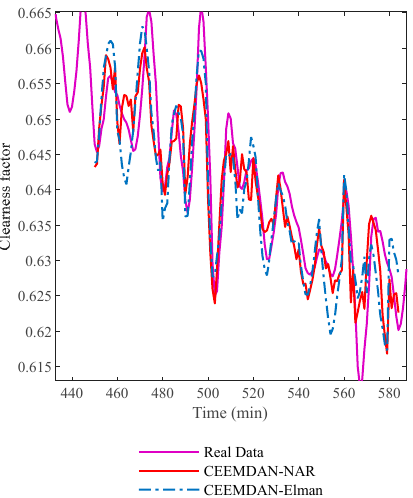
Figure 12. Using EMD to predict at different starting points. 350 min, ( a ) and partial enlarged figure ( b ).